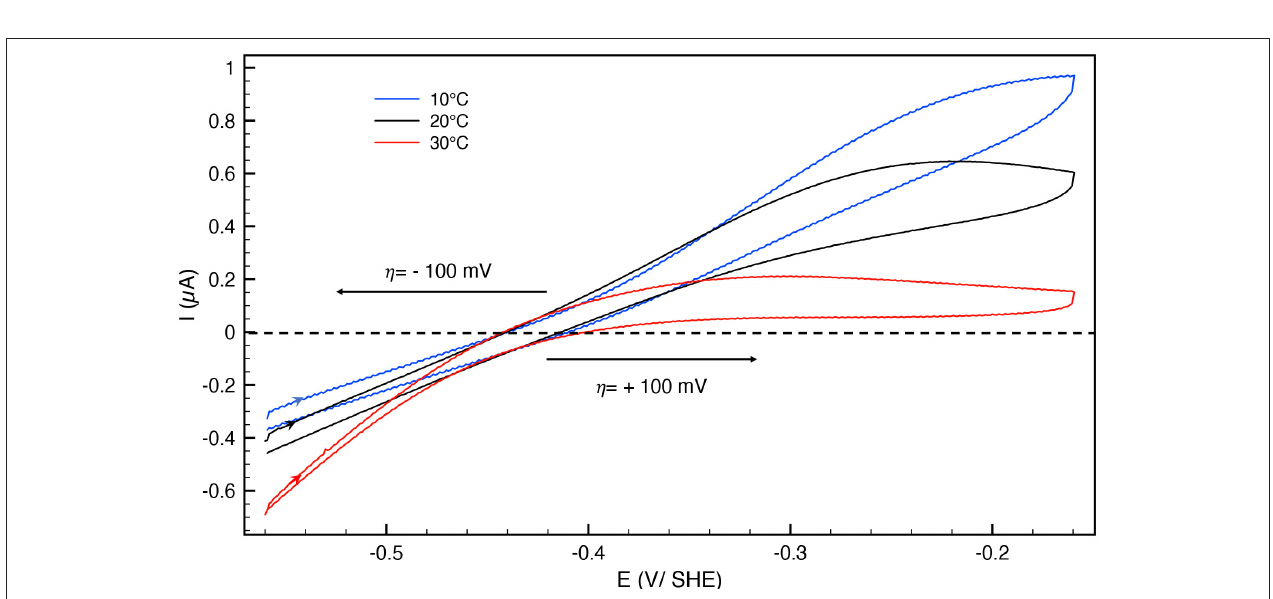
FIGURE 2 | Cyclic voltammograms of anaerobically-purified Hnd hydrogenase adsorbed on PGE electrode as a function of temperature; blue: 10 ◦ C, black: 20 ◦ C, red: 30 ◦ C. Scan rate: 20 mV/s, 1 bar H 2 , phosphate buffer pH 7, ω = 3,000 rpm.